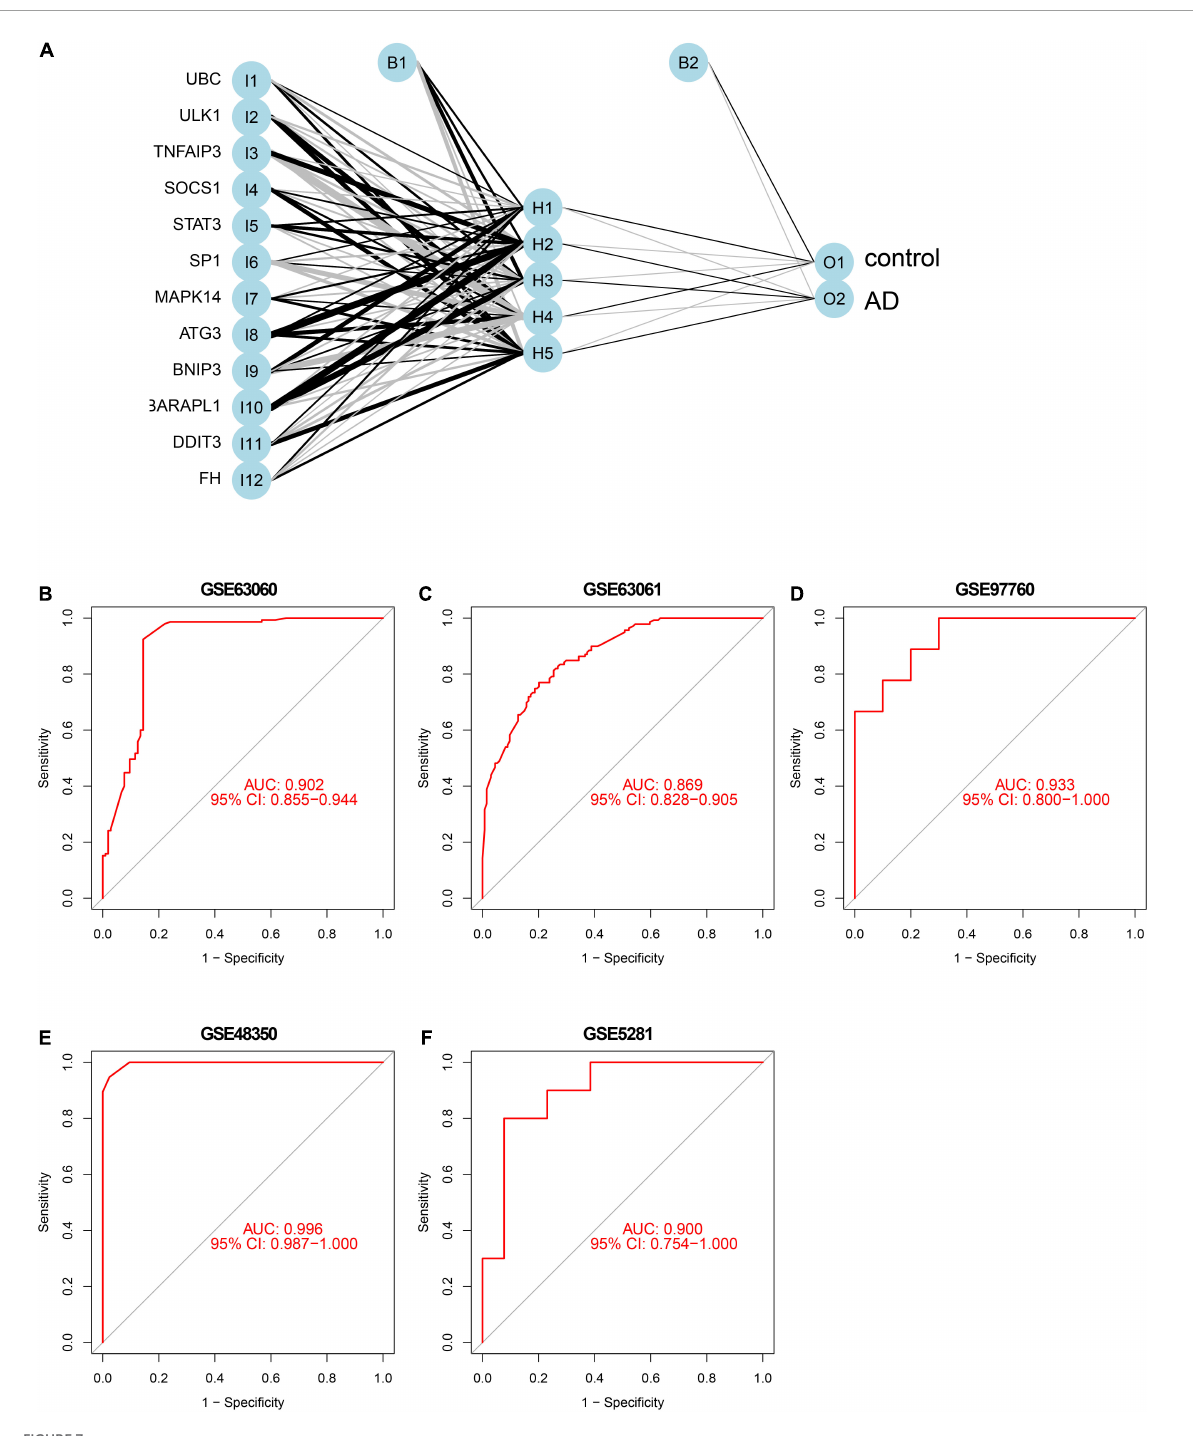
FIGURE7 Neural network and ROC curve analysis. (A) Neural network visualization curves of (B) GSE63060, (C) GSE63061, (D) GSE97760, (E) GSE48350, and (F) GSE5281, respectively. AUC, area under the curve.